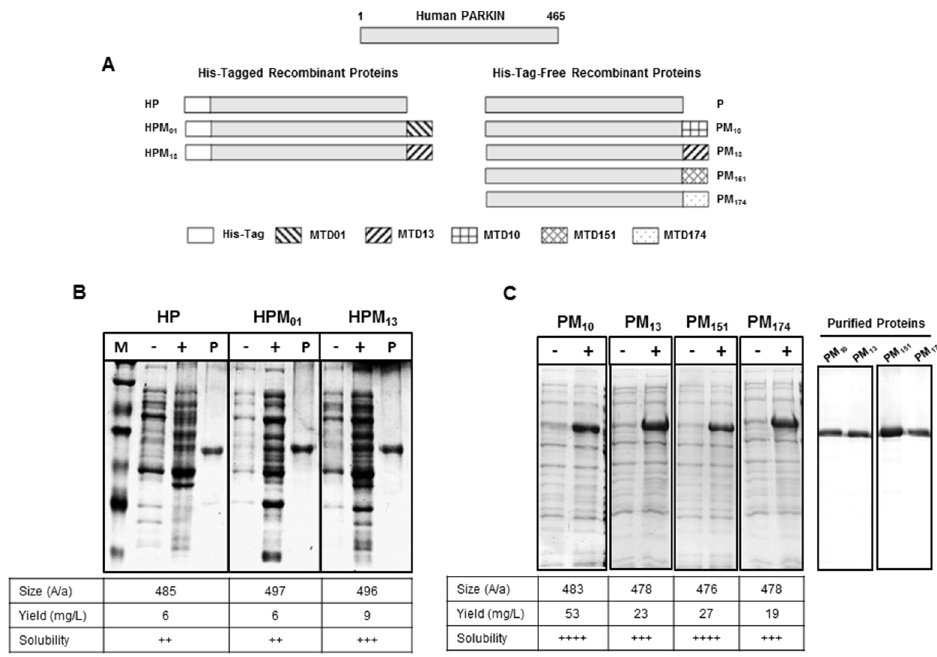
Figure 1. Structure and expression of MTD-parkin fusion proteins. ( A ) Structures of parkin fusion proteins. 6xHis-tagged parkin proteins (left) contained His-tag (HP) only or together with MTD01 (HPM 01 ) or MTD13 (HPM 13 ) sequences. Parkin proteins without the 6xHis tag (right) included native parkin (P) and proteins containing C-terminal MTD10 (PM 10 ), MTD13 (PM 13 ) MTD151 (PM 151 ) and MTD174 (PM 174 ) sequences. ( B–C ) Protein expression in E. coli . SDS PAGE analysis of cell lysates before ( 2 ) and after ( + ) IPTG induction; aliquots of Ni 2 + affinity purified proteins (P); and molecular weight standards (M). The size (number of amino acids), yield (mg/L) and solubility of each recombinant protein are indicated. Solubility was scored on a 4-point scale from highly soluble, with little tendency to precipitate ( ++++ ), to largely insoluble proteins ( + ). doi:10.1371/journal.pone.0102517.g001 hydroxylase status of primary rat neurons treated in vitro with 6- hydroxydopamine (data not shown).